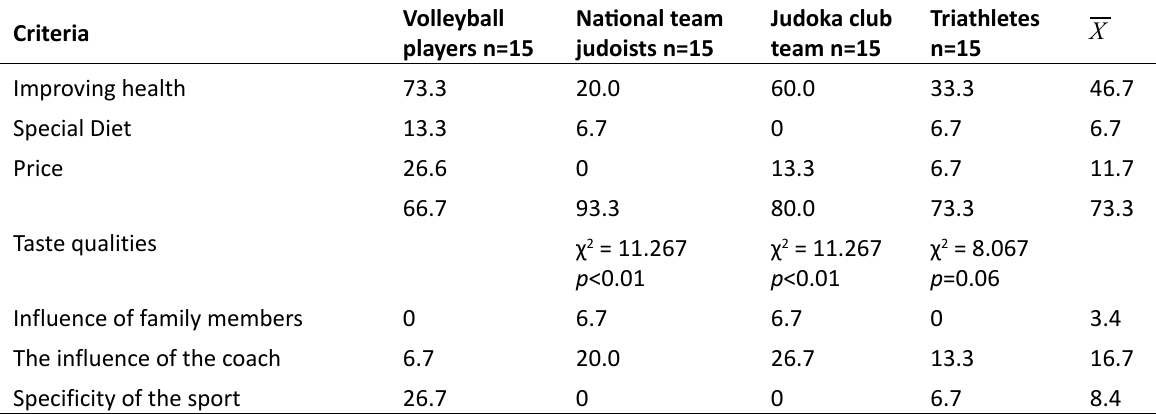
Table 4. Percentage Distribution Source of the Received Information About Nutrition